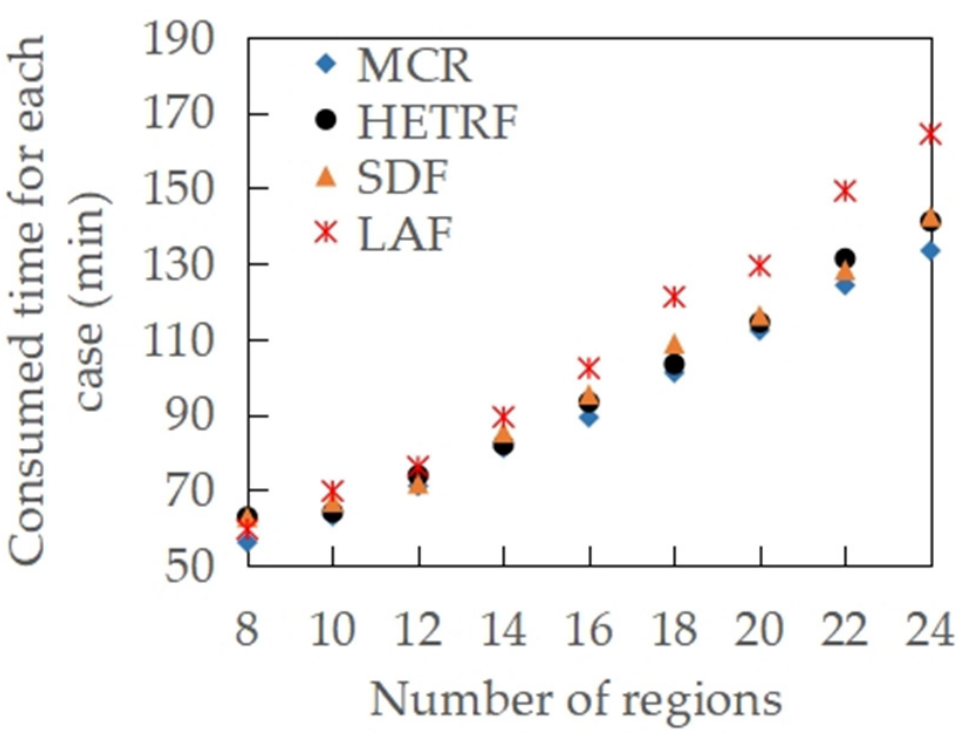
Figure 11. Time consumption changes with the number of regions.